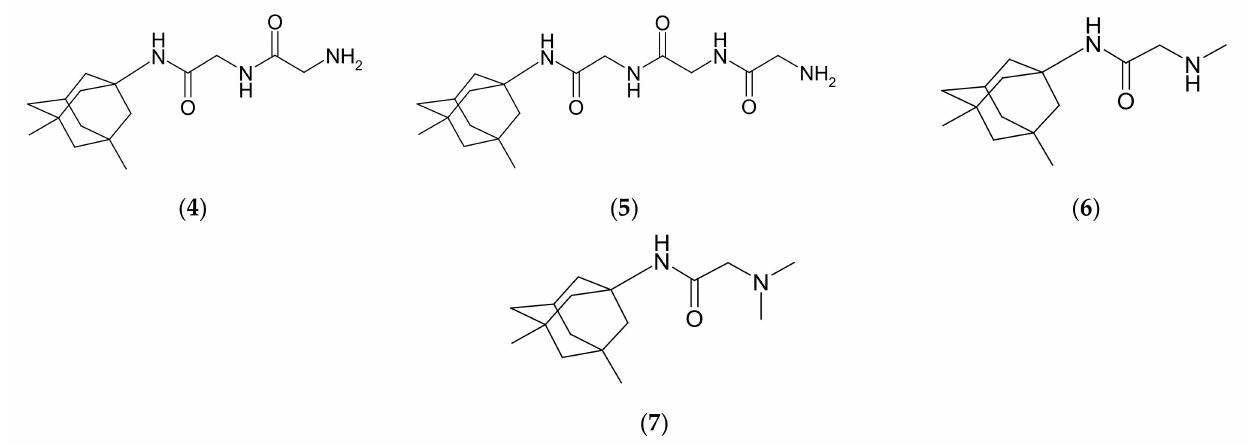
Figure 2. Chemical structures of the studied compounds. modafinil-memantine. ( 1 );